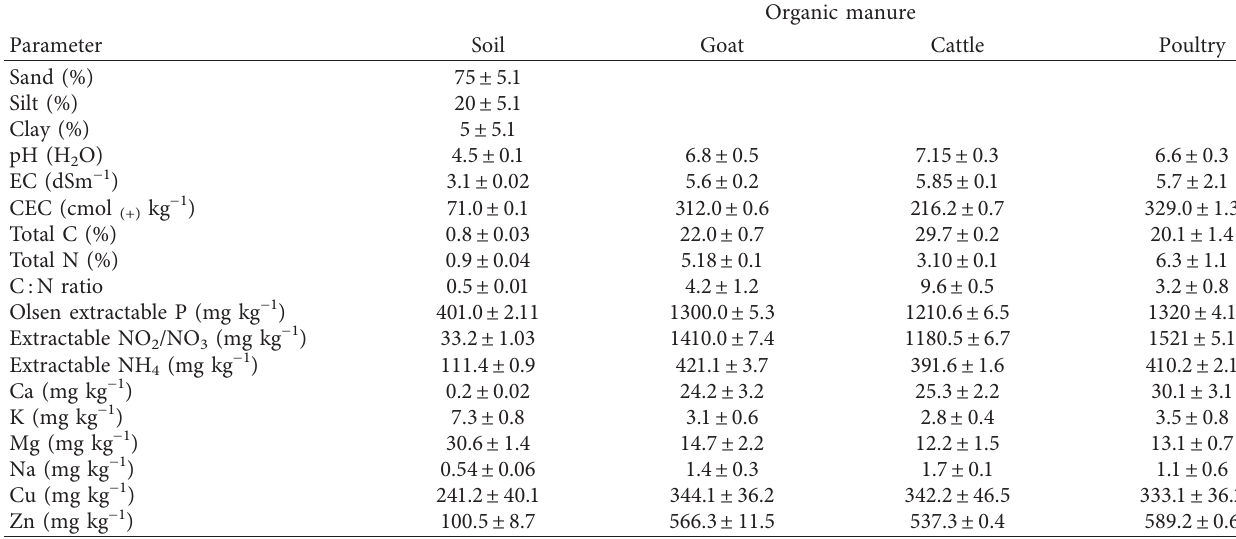
Table 2: The initial chemical properties of the soil at the Seke Teachers College (STC), experimental field, and organic manures used in the study.